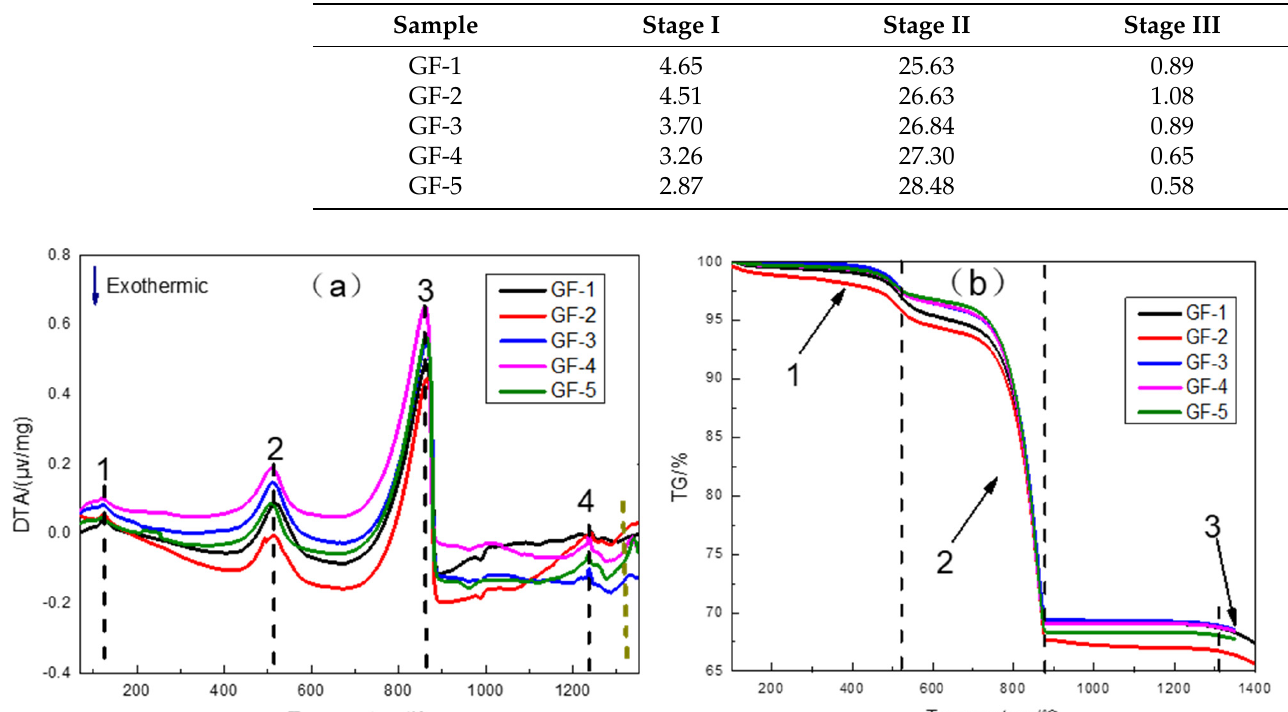
Figure 1. ( a ) DTA (1-Peak 1, 2-Peak2, 3-Peak3, 4-Peak4) and ( b ) TG (1-Stage I, 2-Stage II, 3-Stage III) curves of HBSC raw materials. Table 5. Key temperature point of exothermic or endothermic peaks in DTA curves (°C).